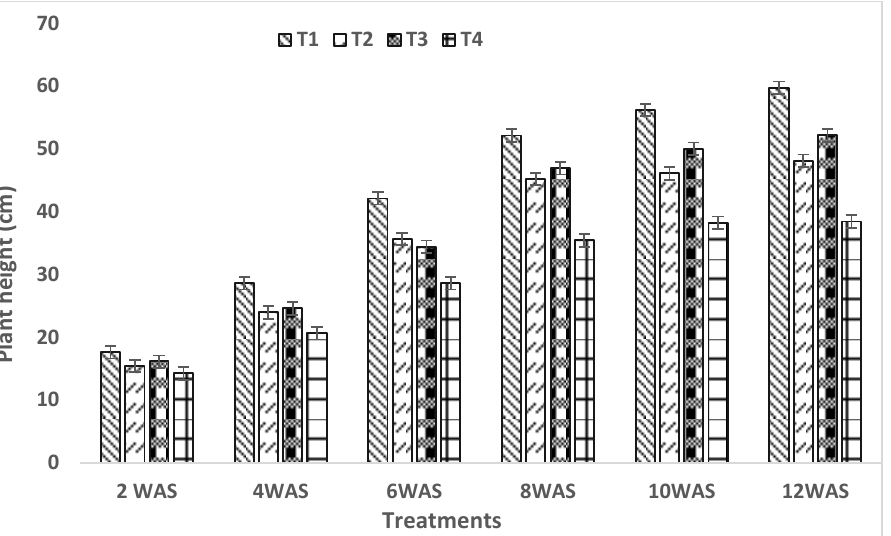
Fig. 1 Effect of manure application on okra plant height T1, 30 t ha -1 Poultry manure; T2, 30 t ha -1 Cow manure; T3, 30 t ha -1 Pig manure; T4, Control, without manure application, bars indicate least significant difference at 5% probability (p < 0.05).